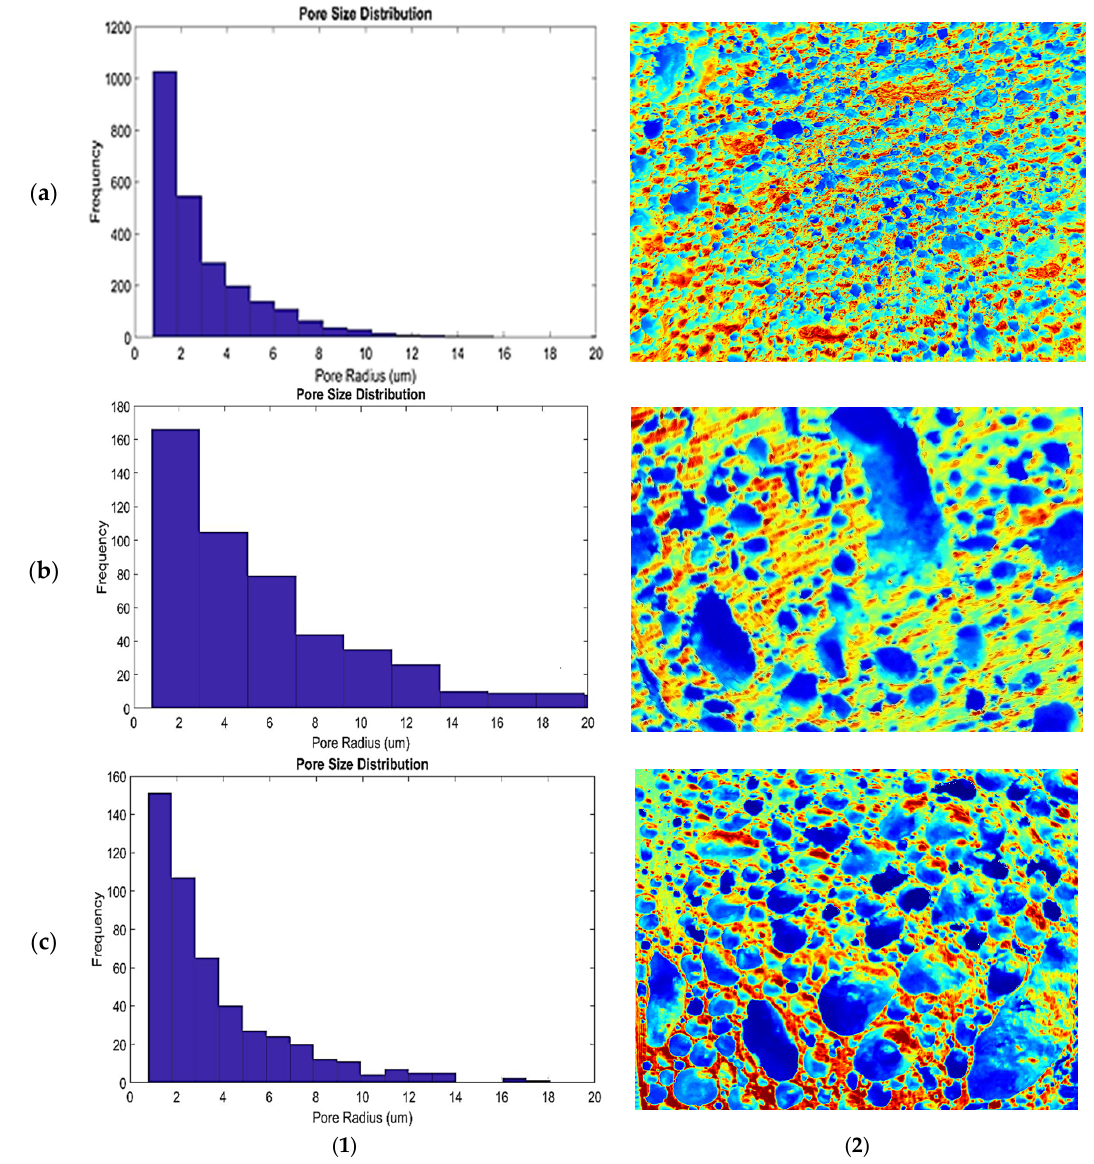
Figure 5. Frequency distribution of pore area ( 1 ), and Scaled labeled images ( 2 ) for ( a ) AlMg4Si8 foam for 8 min ( b ) MWCNT coated nickel reinforced AlMg4Si8 foam for 8 min ( c ) MWCNT coated nickel reinforced AlMg4Si8 foam for 9 min.